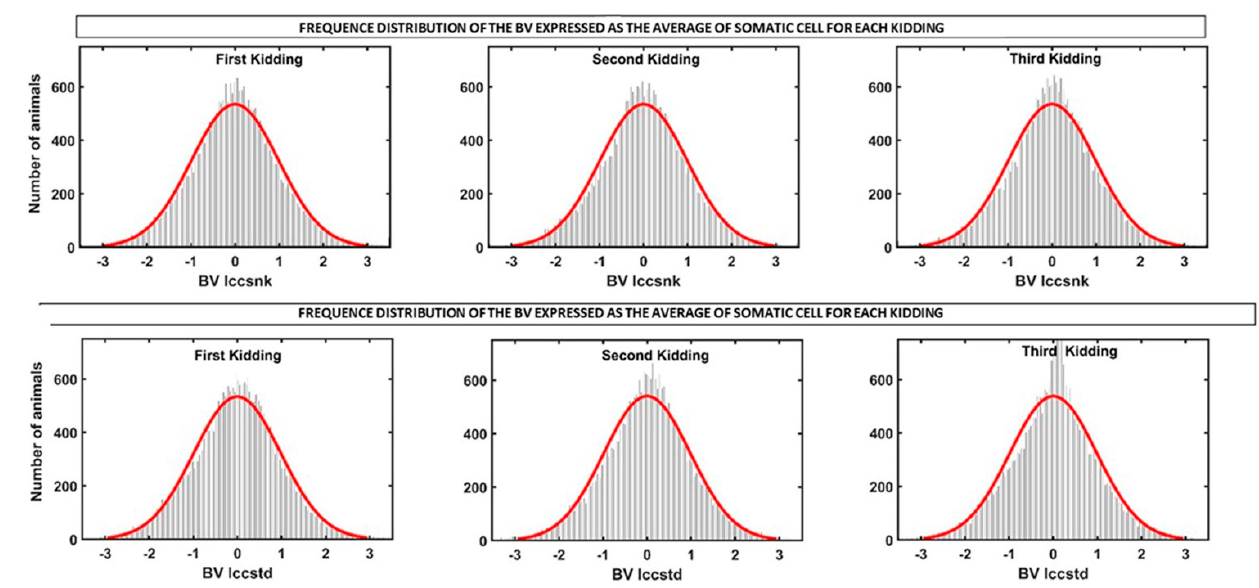
Figure 5. Frequency distribution of the breeding value for SCSTD and SCSPT of all goats throughout the first three parities.